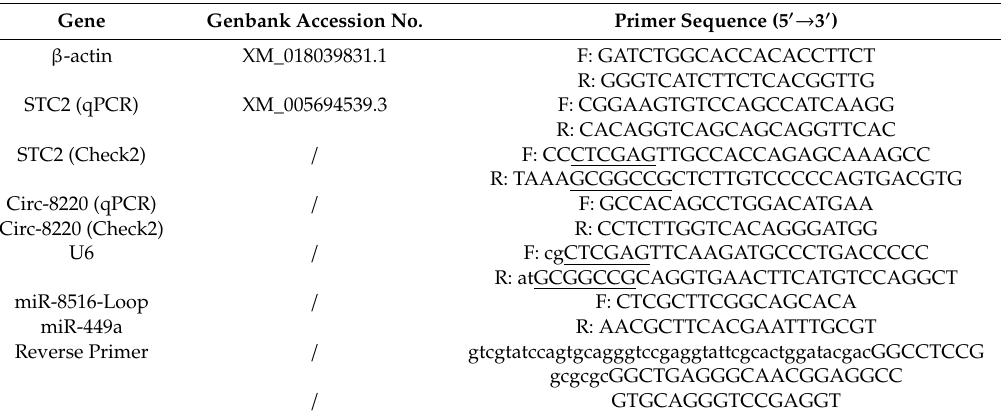
Figure A2. CircRNA8220 promote cell proliferation and enhance the synthesis of β -casein and triglycerides in GMEC in vitro.